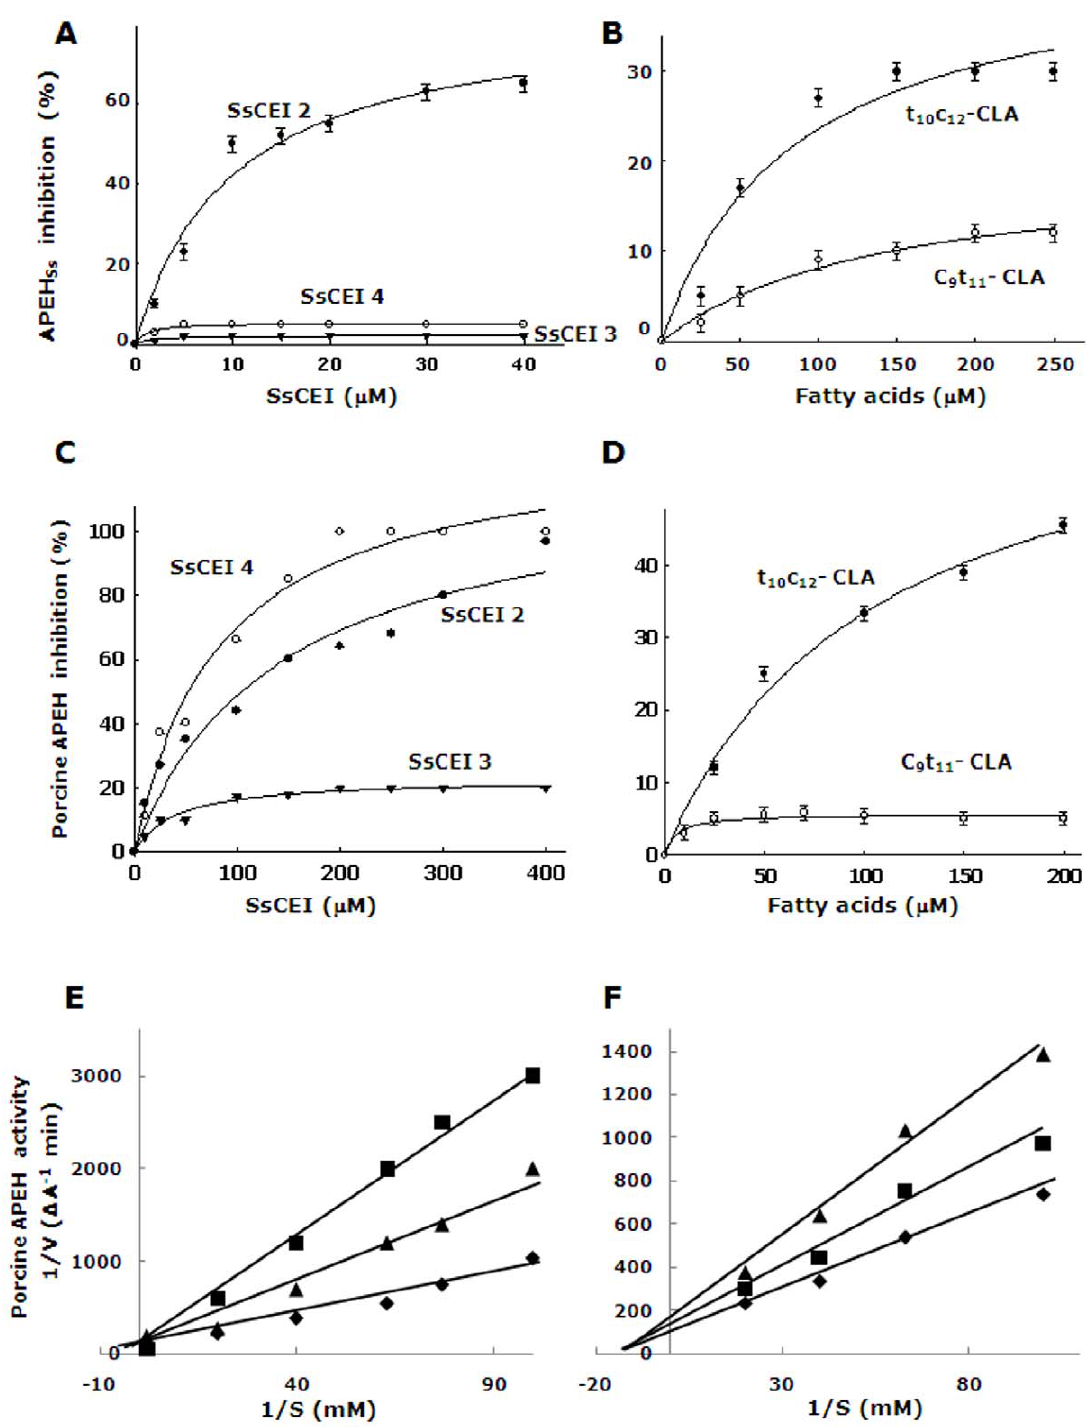
Figure 1. Kinetic analysis of SsCEIs and CLA isomers towards APEHs. Binding of increasing concentrations of the SsCEI peptides (A), and CLA isomers (B) to APEH Ss . Binding of SsCEI peptides (C), and t 10 c 12 -CLA (D) to porcine APEH. The hyperbolic curves indicate the best fits for the data obtained, with IC 50 values calculated from the graphs. Inhibition kinetics analyses with porcine APEH (0.5 nM) at increasing SsCEI 4 concentrations: 100 m M (triangles) and 150 m M (squares) (E). Similarly, inhibition kinetics by increasing t 10 c 12 -CLA concentrations: 50 m M (squares) and 100 m M (triangles) (F). Enzyme incubated without inhibitors were used as control (diamonds) (E, F). The inhibition constants, Ki, were determined by the Lineweaver–Burk equation for competitive and non-competitive inhibition, respectively.